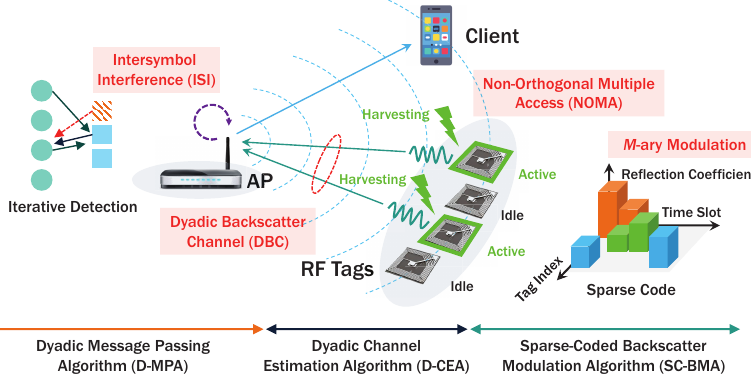
Figure 1. Proposed AmBC network with single AP and multiple RF tags employing ambient RF energy harvesting and backscatter communications using sparse code.